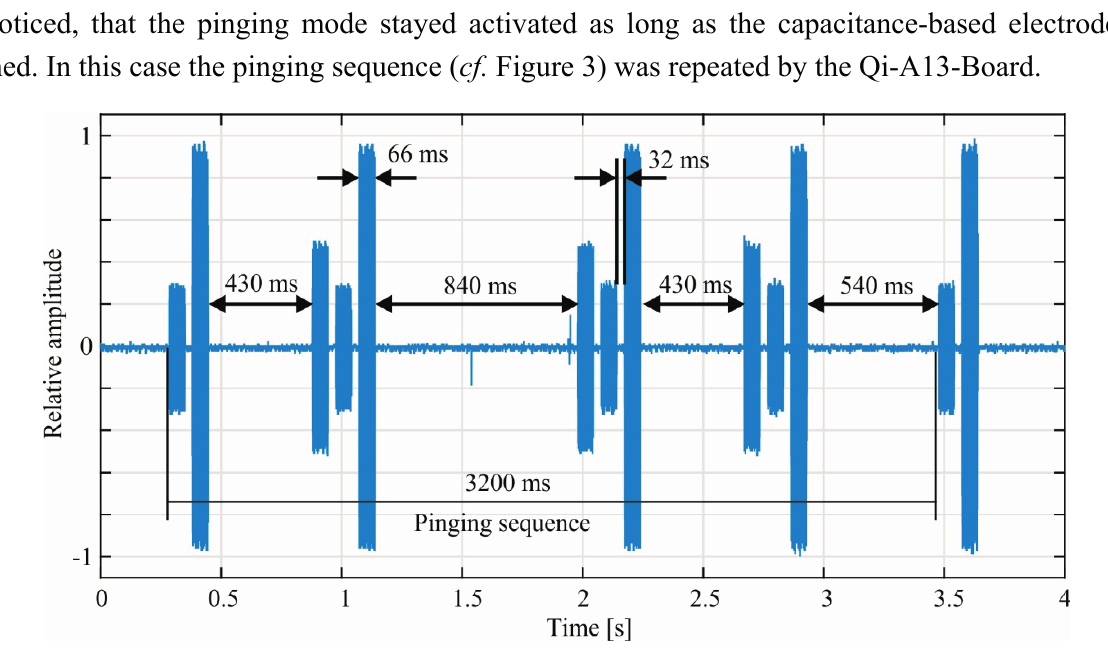
Figure 3. Pinging sequence recorded during pinging mode of the